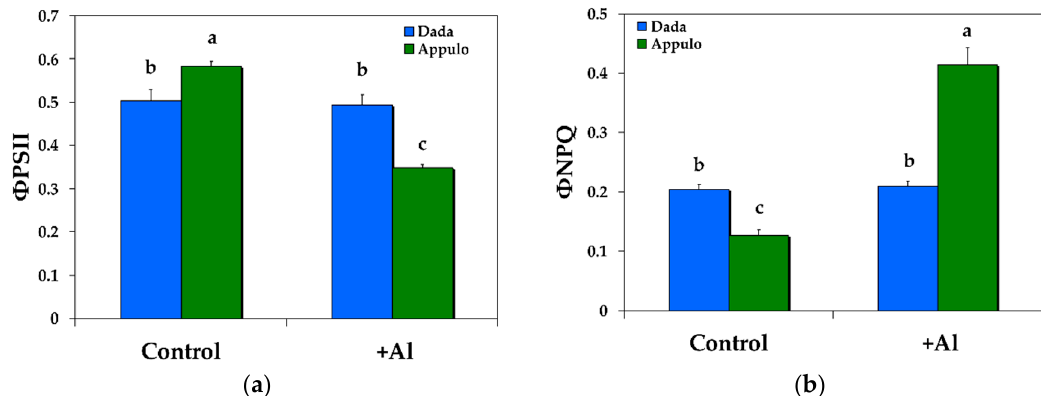
Figure 2. Changes in the balance between light capture and energy use in the triticale ‘Dada’ and the durum wheat ‘Appulo E’; ( a ) the quantum efficiency of photosystem II (PSII) photochemistry (photochemical utilization) ( Φ PS ΙΙ ); and ( b ) the quantum yield for dissipation by down regulation in PSII (regulated heat dissipation, a loss process serving for protection) ( Φ NPQ ); under normal growth conditions (control) and under Al 3+ exposure (+Al). Error bars on columns are standard deviations based on five leaves from five plants. Columns with different letters are statistically different ( p < 0.05).